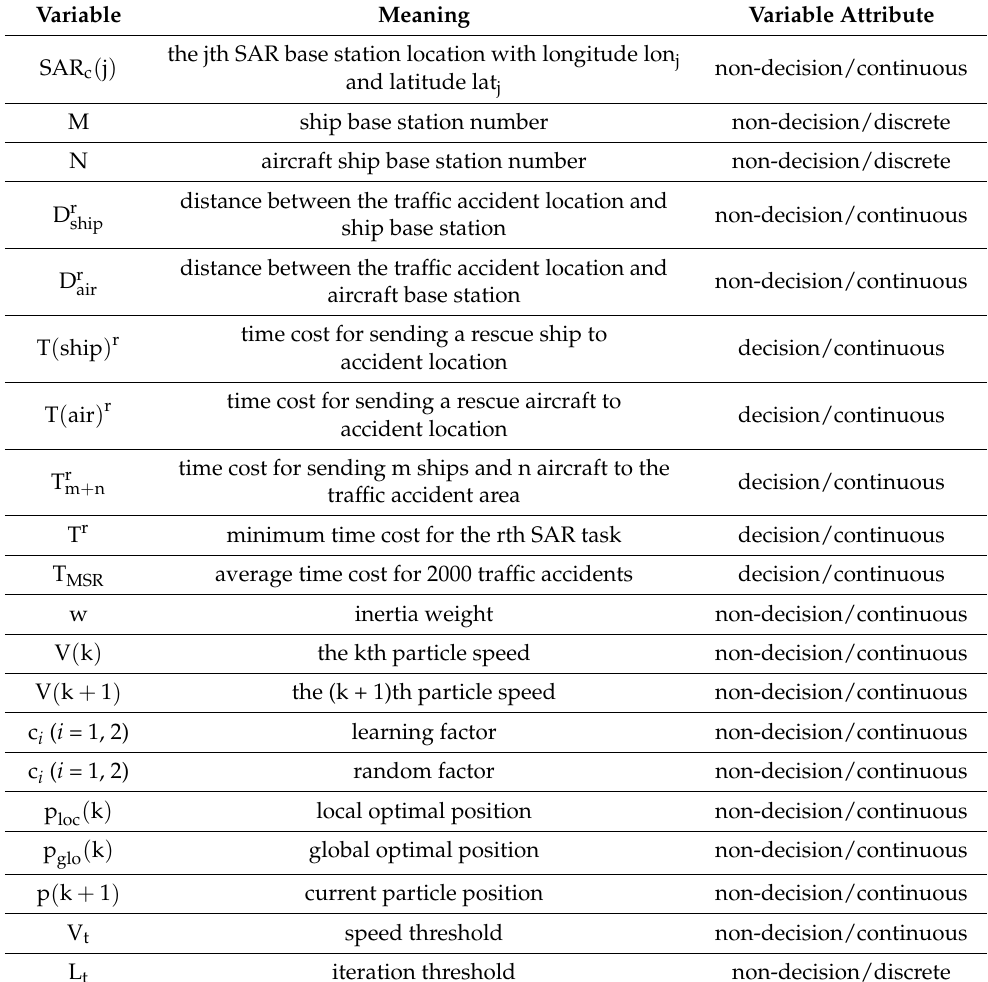
Table 1. Varied variables and the corresponding